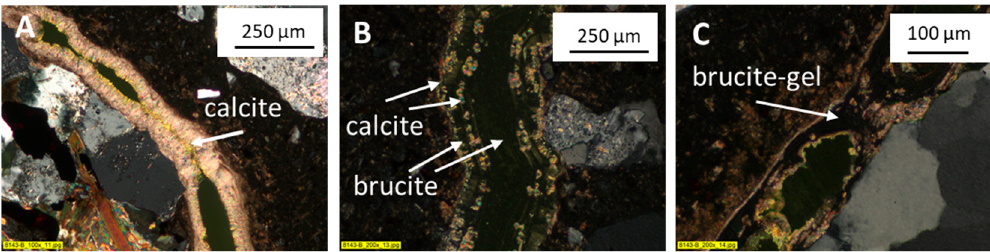
Figure 9. Examples of ( A ) Calcite bridging; ( B ) brucite and calcite, layered and intermixed; ( C ) brucite-gel observed inside the crack of PC-4SF at different crack depth; crack depth from the exterior, ( A ): 4 mm, ( B ): 17 mm, ( C ): 23 mm.